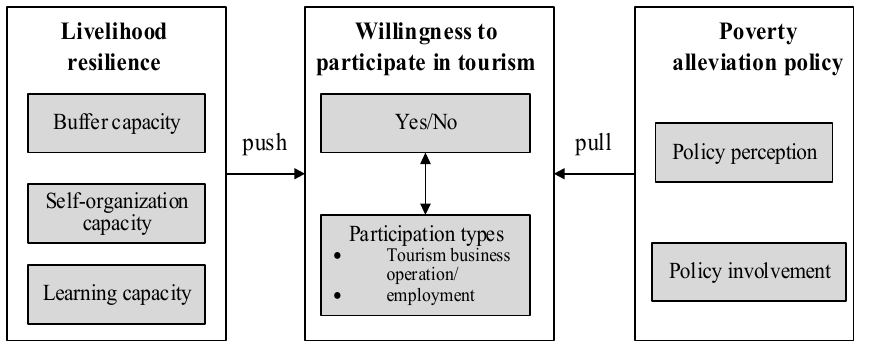
Figure 1. The analytical framework for the willingness to participate in tourism of rural households based on livelihood resilience and poverty alleviation policies.